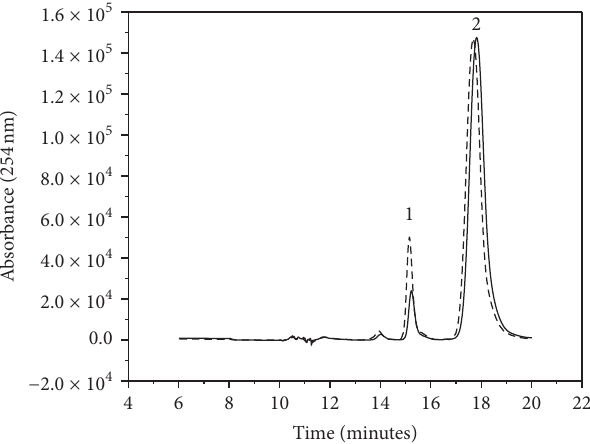
Figure 4: (—) Representative chromatogram of the separation of ATP (2) and ADP (1) by a Luna C18 analytical column. (---) Representative chromatogram of the activity of the immobilized enzyme Tc NTPDase-1-ICER. On-line hydrolysis of ATP (10 𝜇 L of 1.0mmol ⋅ L −1 ) to ADP. Separation obtained by a Luna C18 analytical column coupled to the Tc NTPDase-1-ICER, max = 254 nm. Experi- mental conditions as described in Table 1.